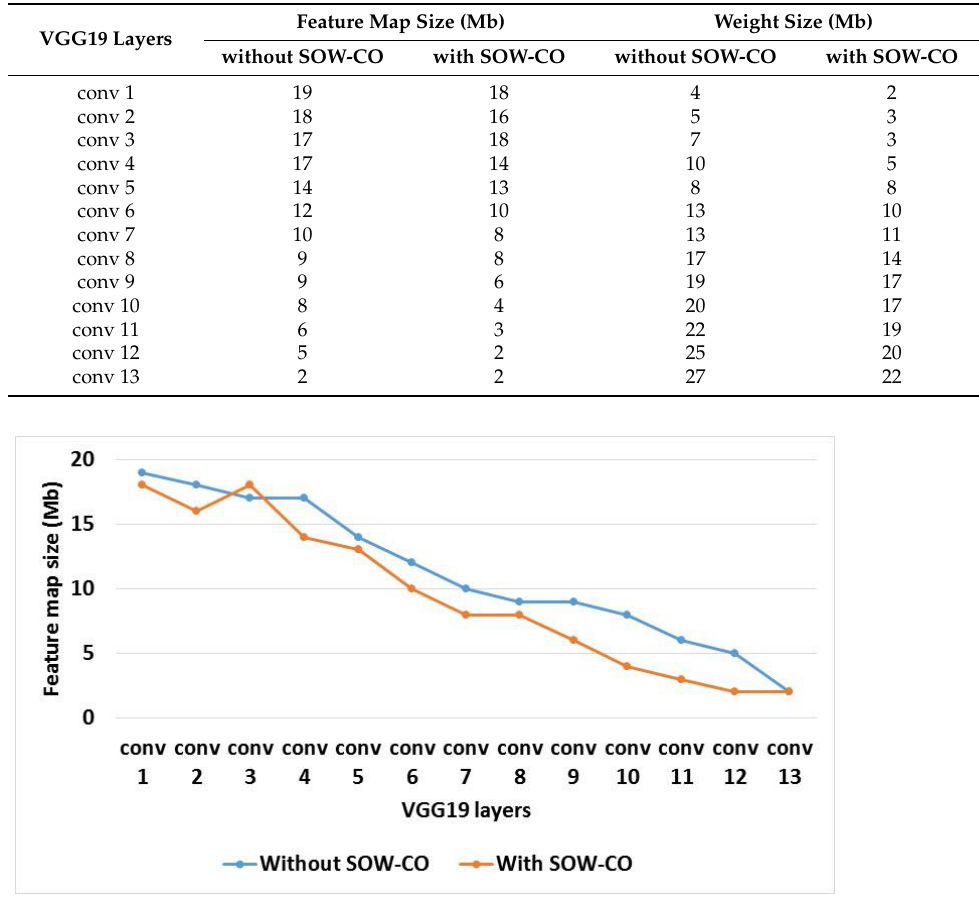
Figure 13. Graphical illustration of feature map size for VGG19.